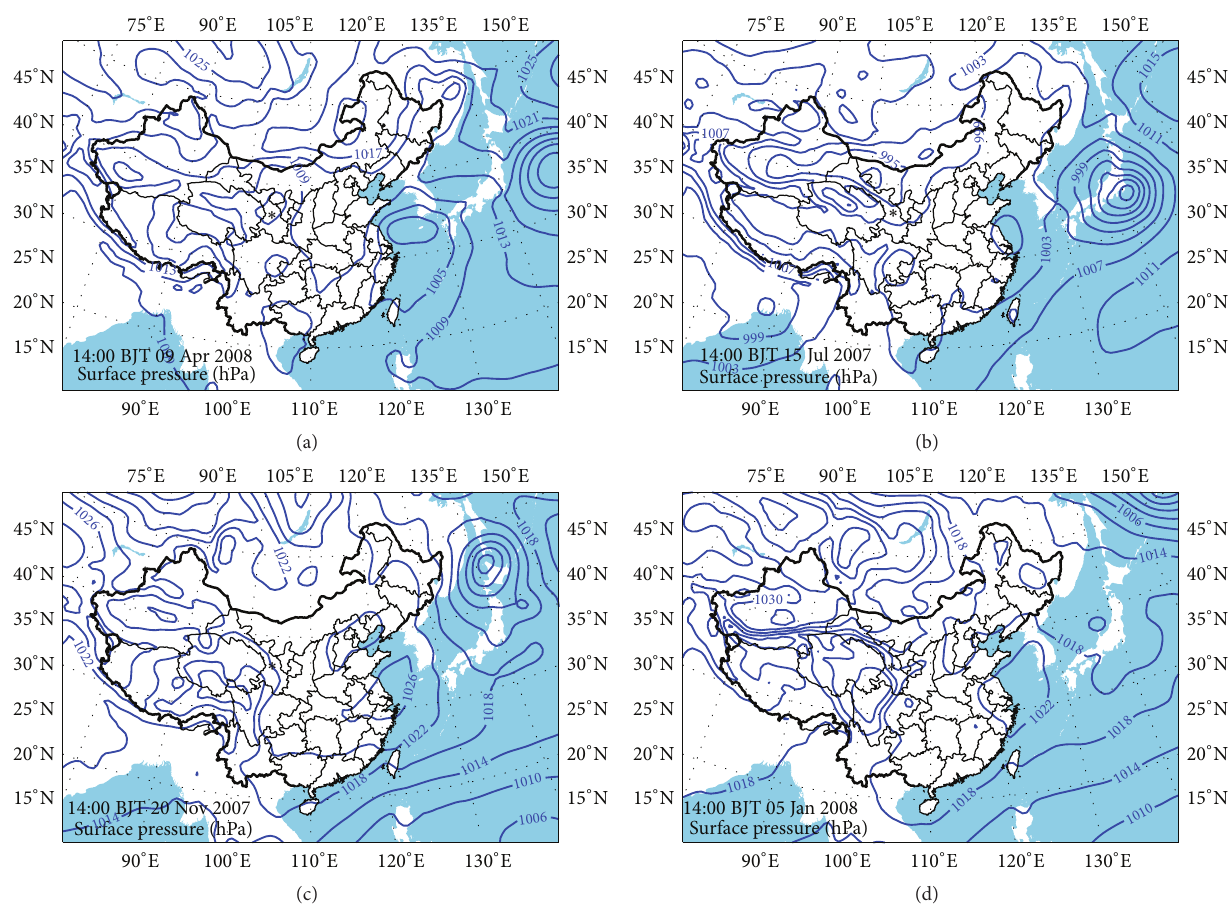
Figure 2: Surface pressure at (a) 14:00 BJT 9 April 2008, (b) 14:00 BJT 15 July 2007, (c) 14:00 BJT 20 November 2007, and (d) 14:00BJT 5 January 2008. Black asterisk denotes measurement